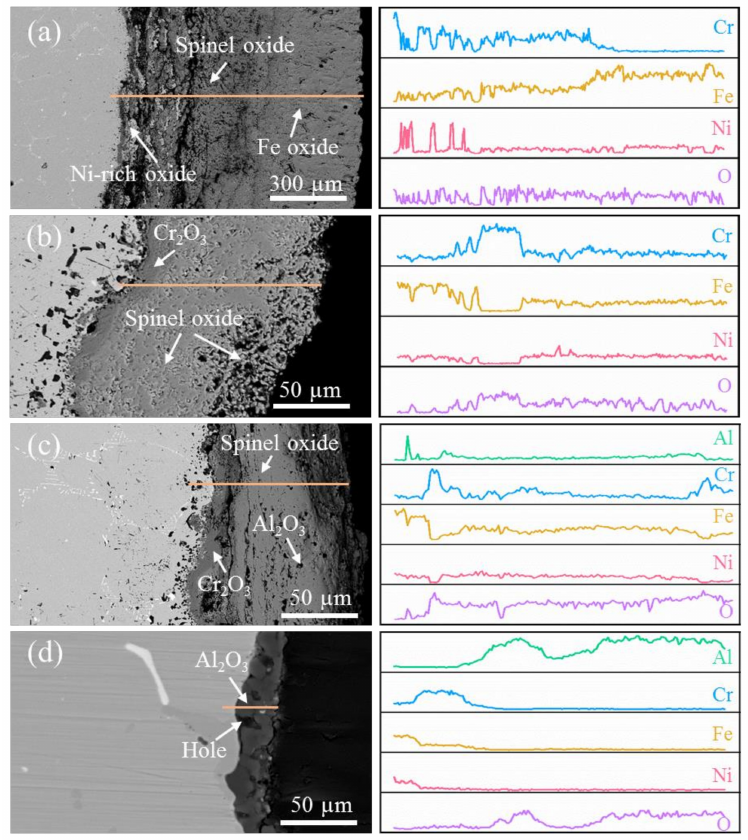
Figure 6. Cross-sectional SEM images of ZG40Cr20Ni20Al x oxidized for 480 h: ( a ) 0, ( b ) 1.76, ( c ) 3.45, and ( d ) 5.34 wt% Al.